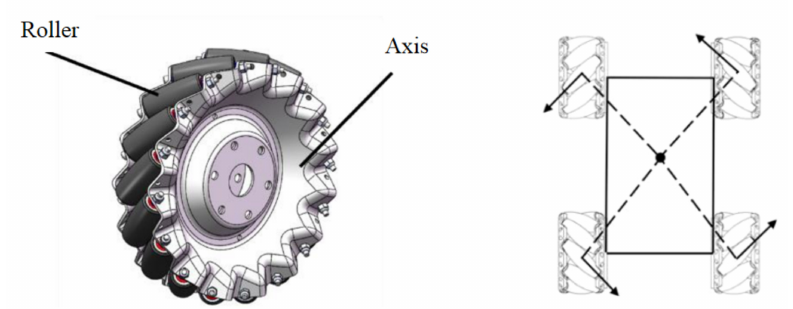
Figure 7. Mecanum wheel and layout of